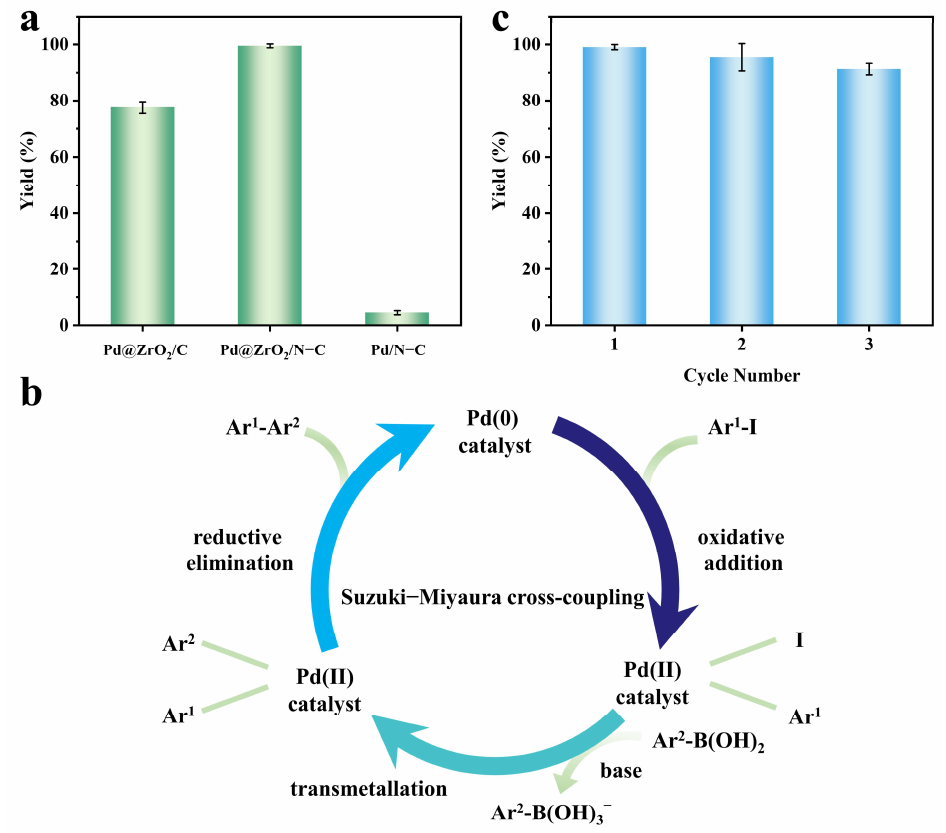
Figure 4. ( a ) Catalytic performance toward the Suzuki reaction over different catalysts. ( b ) Schematics of the Suzuki reaction. ( c ) Recyclability of Pd@ZrO 2 /N–C for the Suzuki reaction.